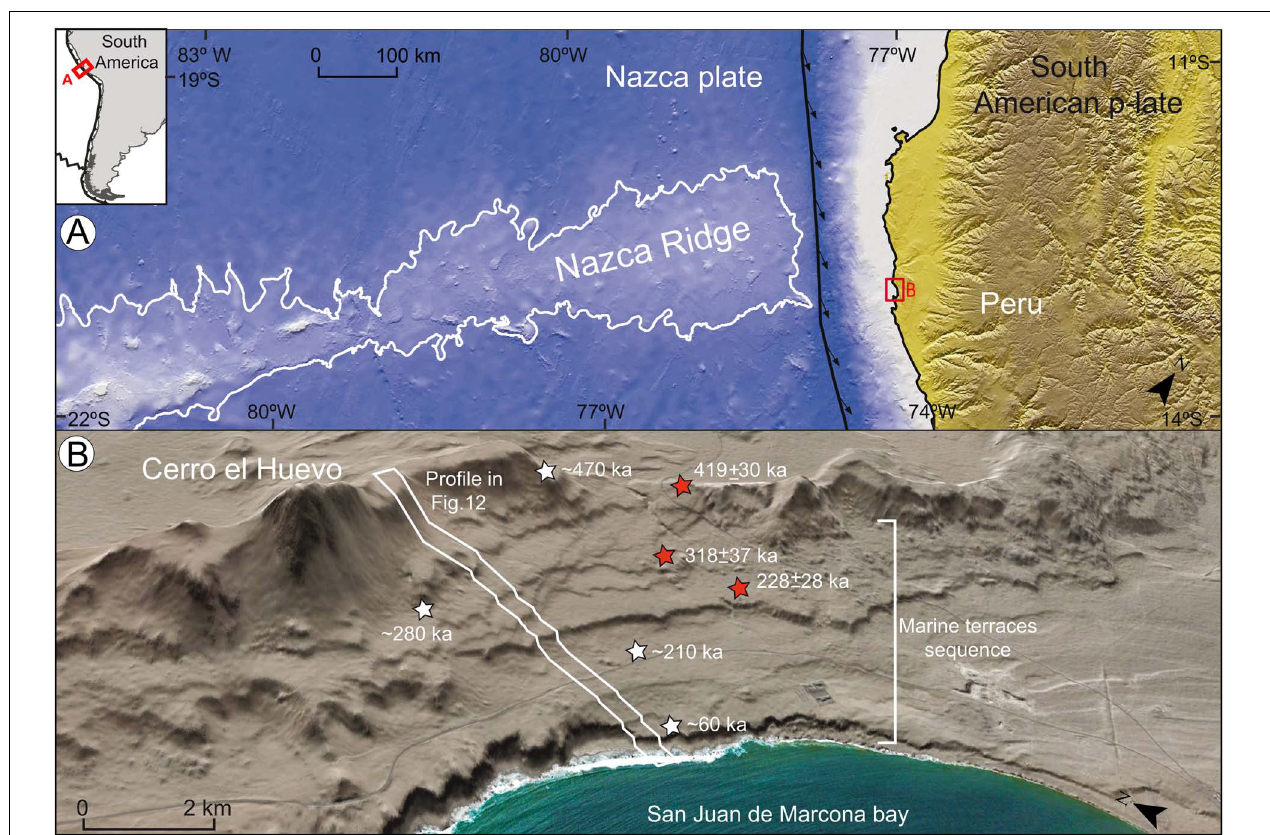
FIGURE 11 | Marine terraces at Cerro el Huevo, in Southern Peru. (A) Tectonic setting highlighting the morphology of the Nazca Ridge. (B) Geoeye Google Earth R (cid:13) image of Cerro el Huevo and the Marcona Bay. Note staircase marine terrace morphology. Red and white stars denote ages from Saillard et al. (2011) and Hsu (1988), respectively (see text for